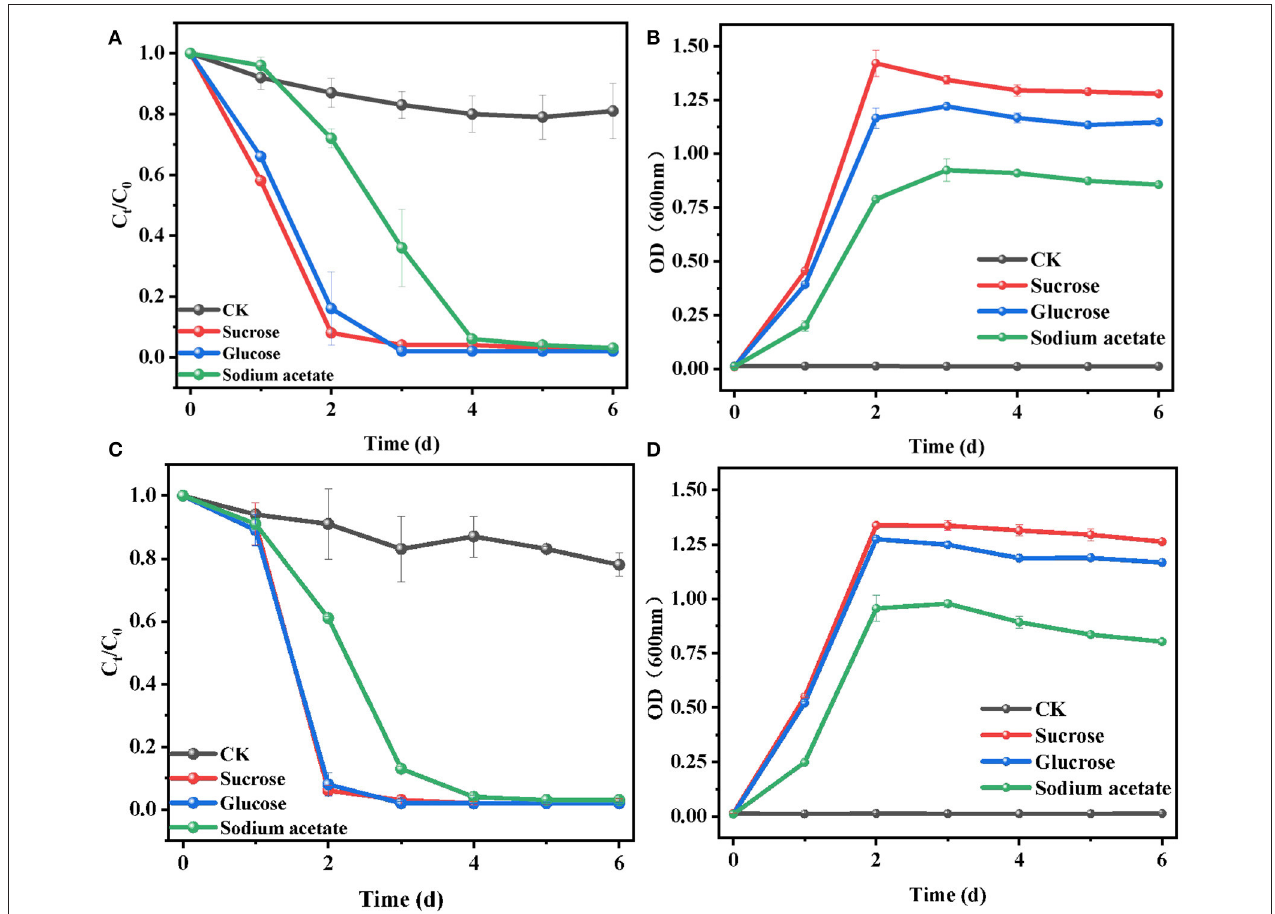
FIGURE 2 | Effects of sucrose, glucose, or sodium acetate on the biodegradation of E2. (A) Degradation efficiency of E2 by C. utilis CU-2; (B) cell growth of C. utilis CU-2, measured with optical density (OD) at λ = 600nm; (C) degradation efficiency of E2 by L. casei LC-1; (D) cell growth of L. casei LC-1, measured with OD at λ = 600nm. The concentrations of all carbon sources were 1.2 g/L, and CK represented the control group without carbon source added ([E2] 0 = 10 µ M, the initial pH = 7.0 ±